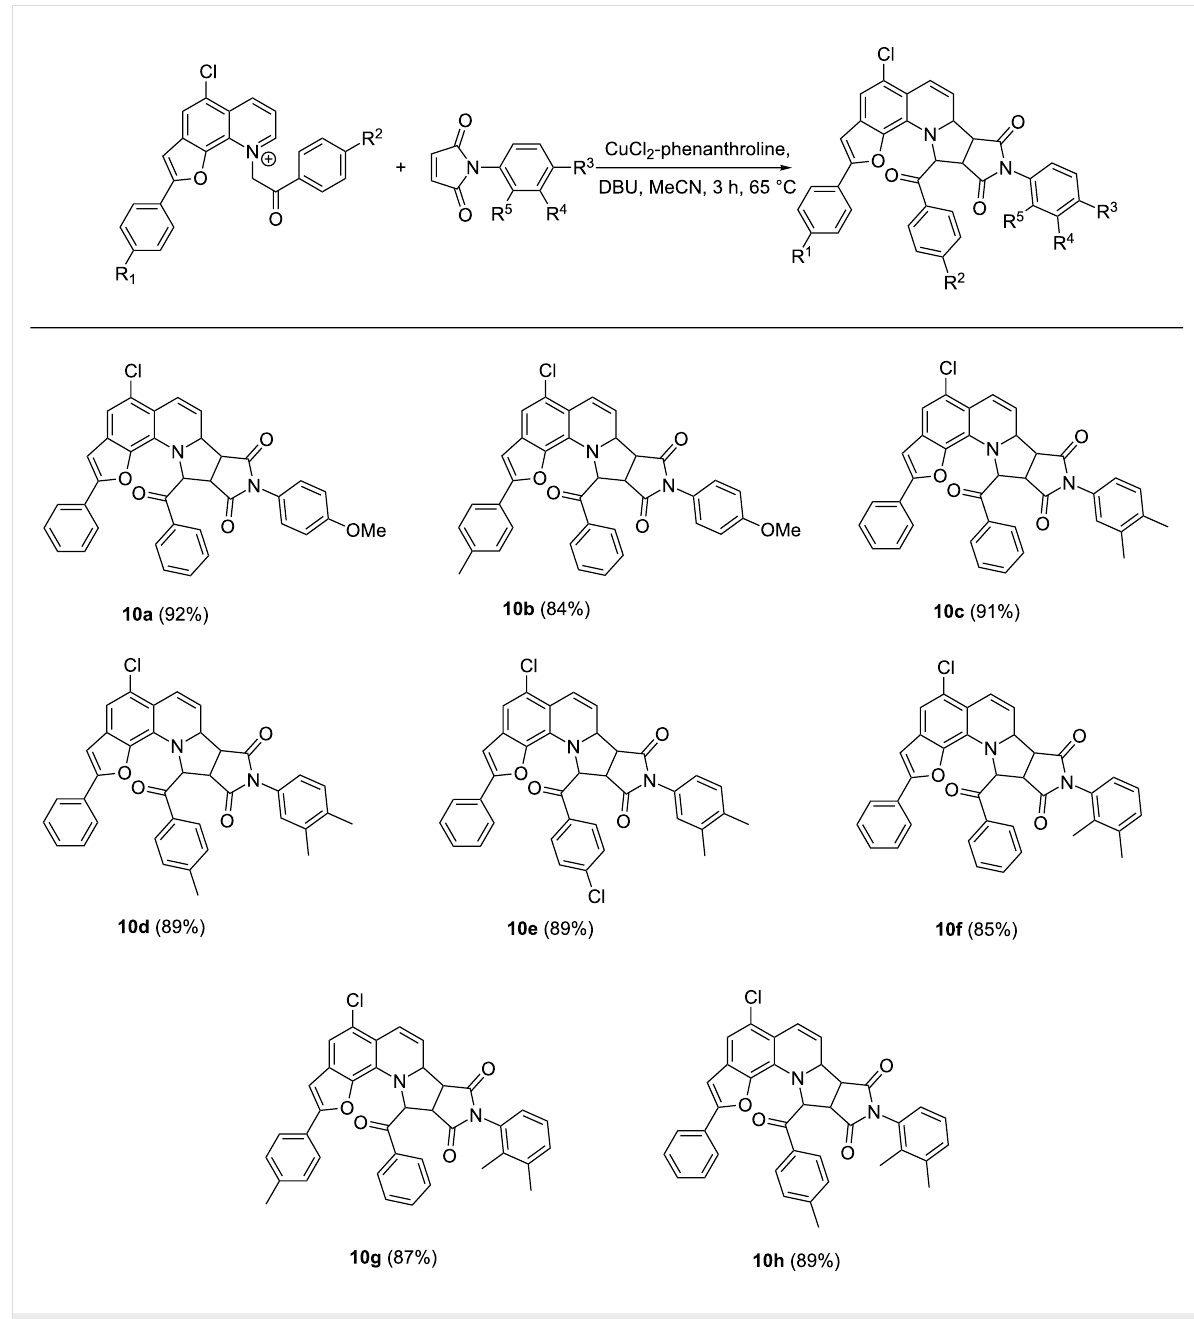
Scheme 4: Synthesis of pyrrolo[3 ′ ,4 ′ :3,4]pyrrolo[1,2- a ]furoquinoline analogues under the optimized